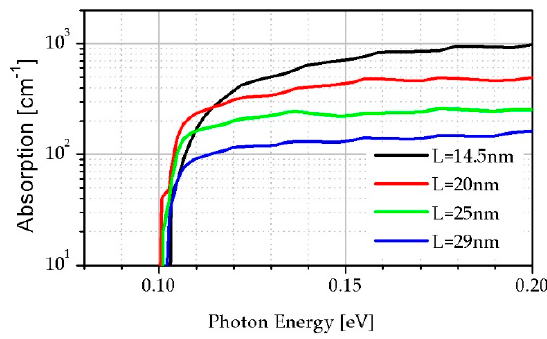
Figure 3. α theoretical simulation versus photon energy for the strain-balanced SL InAs/InAsSb.